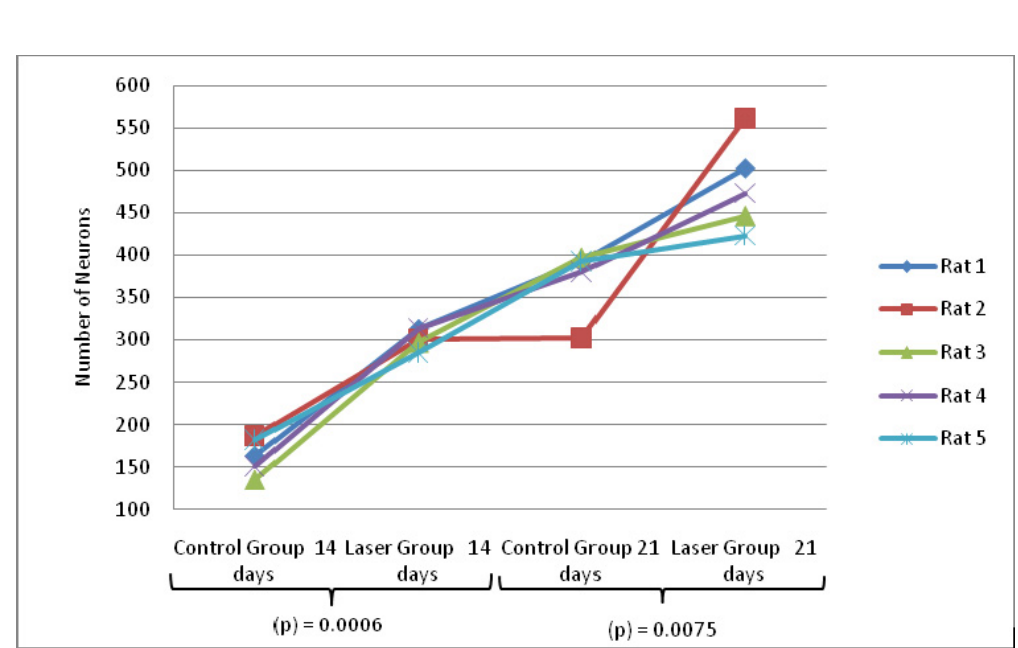
FIGURE 4 – Neurons in histological findings at groups in 14 and 21 days. Source: Fieldwork archive, 2010.